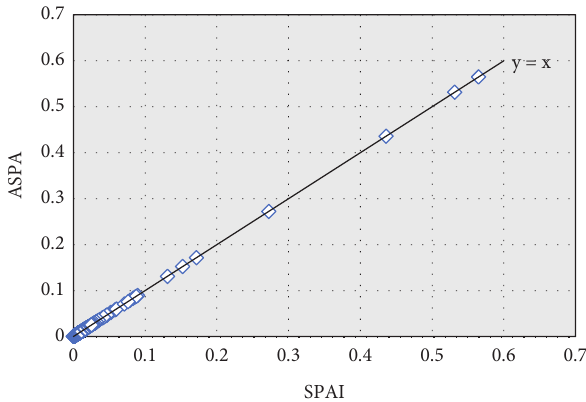
Figure 9: The value distribution of SPAI and ASPA.